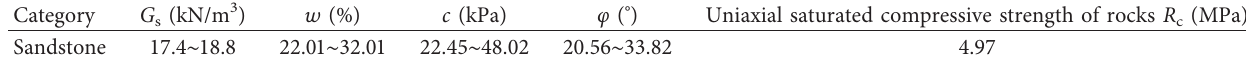
Table 1: Geotechnical properties of rock samples in the field test area.